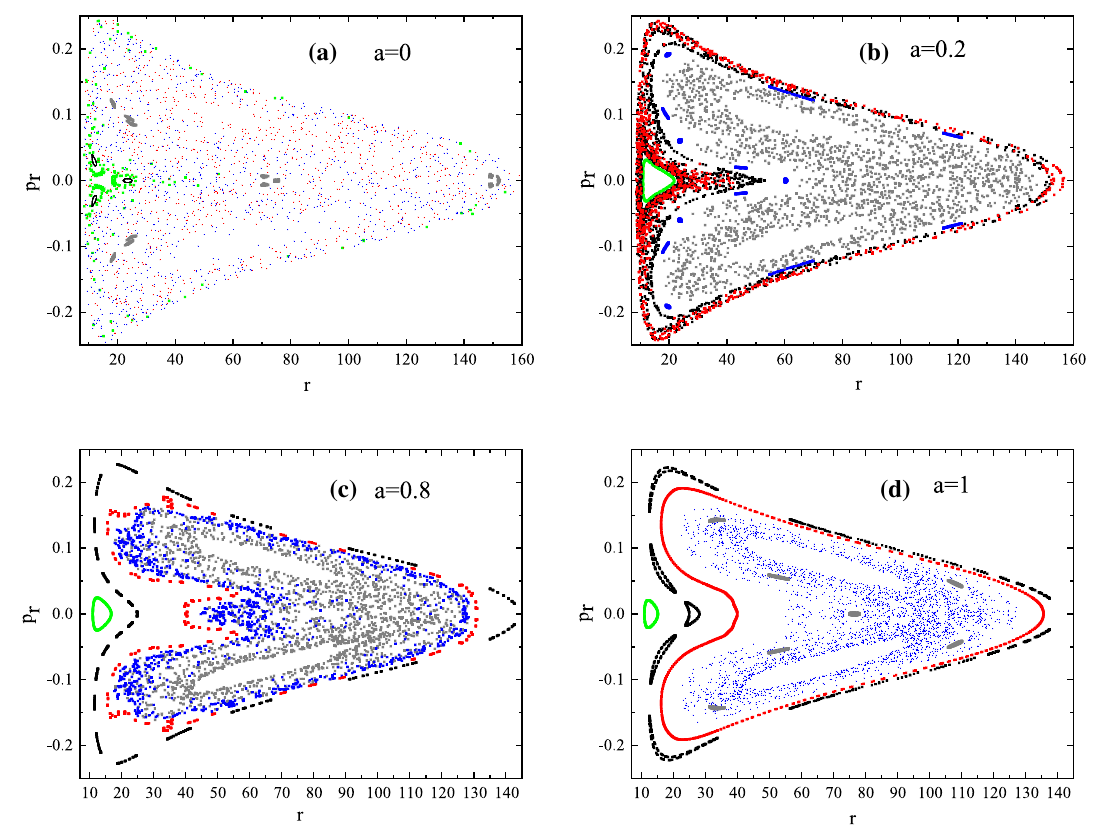
Fig. 3 Same as Fig. 1b, but for different values of the black hole’s angular momentum a . Here, the magnetic parameter β = 1 × 10 − 3 . An increase of a seems to weaken the extent of chaos from the global phase space structure